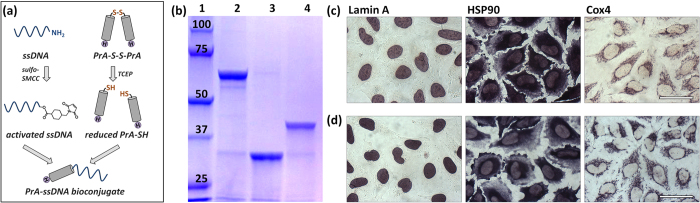
Preparation and characterization of PrA-ssDNA tags.(a) Scheme of PrA-ssDNA conjugation procedure. Amine-functionalized ssDNA is activated by sulfo-SMCC, while HIS-tagged cysteine-terminated PrA (supplied in an oxidized PrA-S-S-PrA form) is reduced by TCEP. Activated ssDNA and reduced PrA are reacted to form covalent PrA-ssDNA bioconjugates and purified from the excess ssDNA with HIS SpinTrap column. (b) Verification of PrA-ssDNA conjugation and purity with SDS-PAGE: (1) Reference protein ladder (KDa); (2) PrA-S-S-PrA dimer; (3) PrA-SH reduced by TCEP; (4) PrA-ssDNA bioconjugate. (c,d) Functionality of PrA-ssDNA tags was assessed by staining of model targets (Lamin A, HSP90, and Cox4) in fixed HeLa cells with pre-assembled 1′Ab/PrA-ssDNA probes followed by complementary ssDNA′-AP (c) in comparison to conventional 2-step immunostaining with unmodified 1′Ab followed by 2′Ab-AP probes (d). Scale bar, 50 μm.